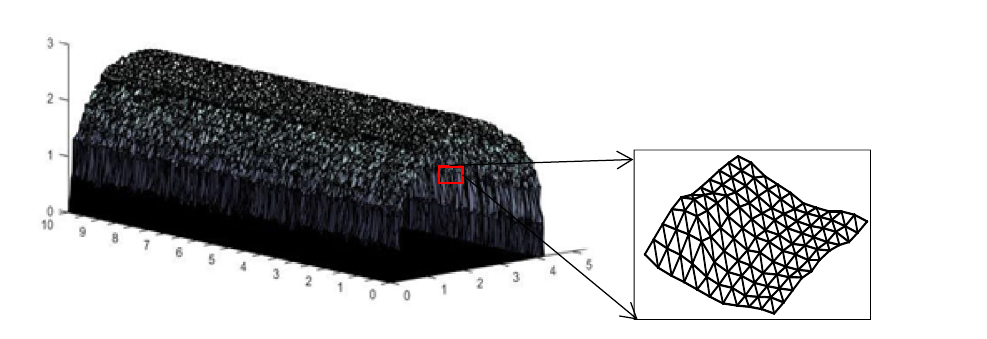
Figure 2. Tunnel model